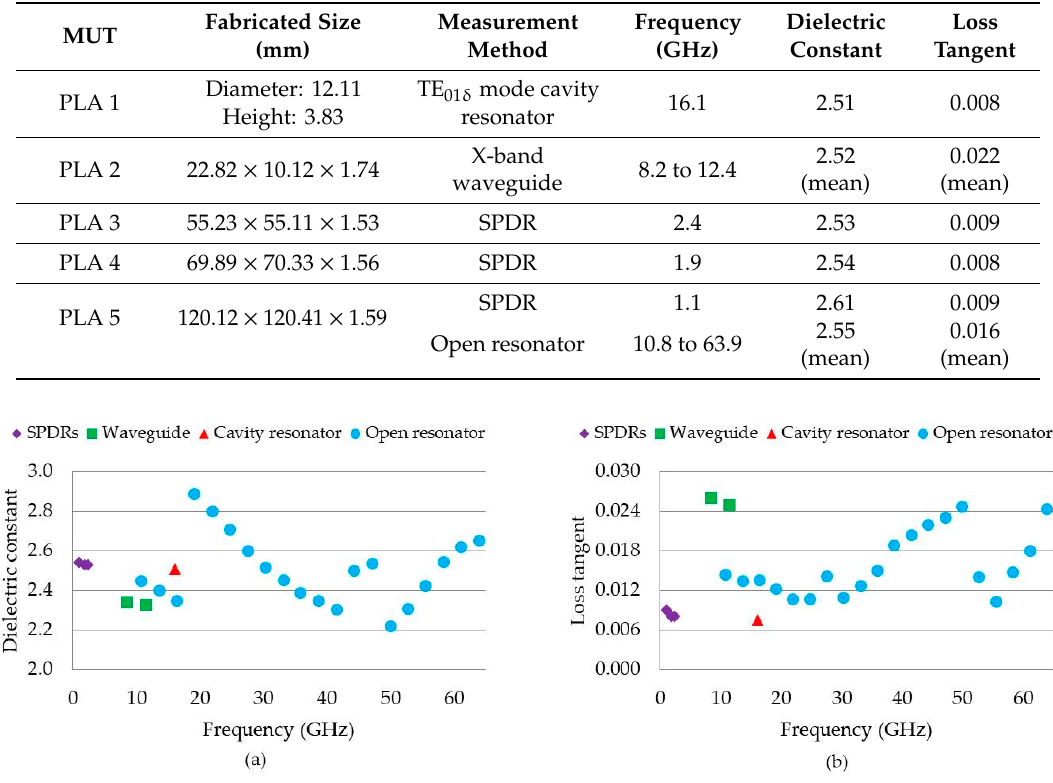
Figure 11. Measured ( a ) dielectric constant and ( b ) loss tangent of PLA MUTs.